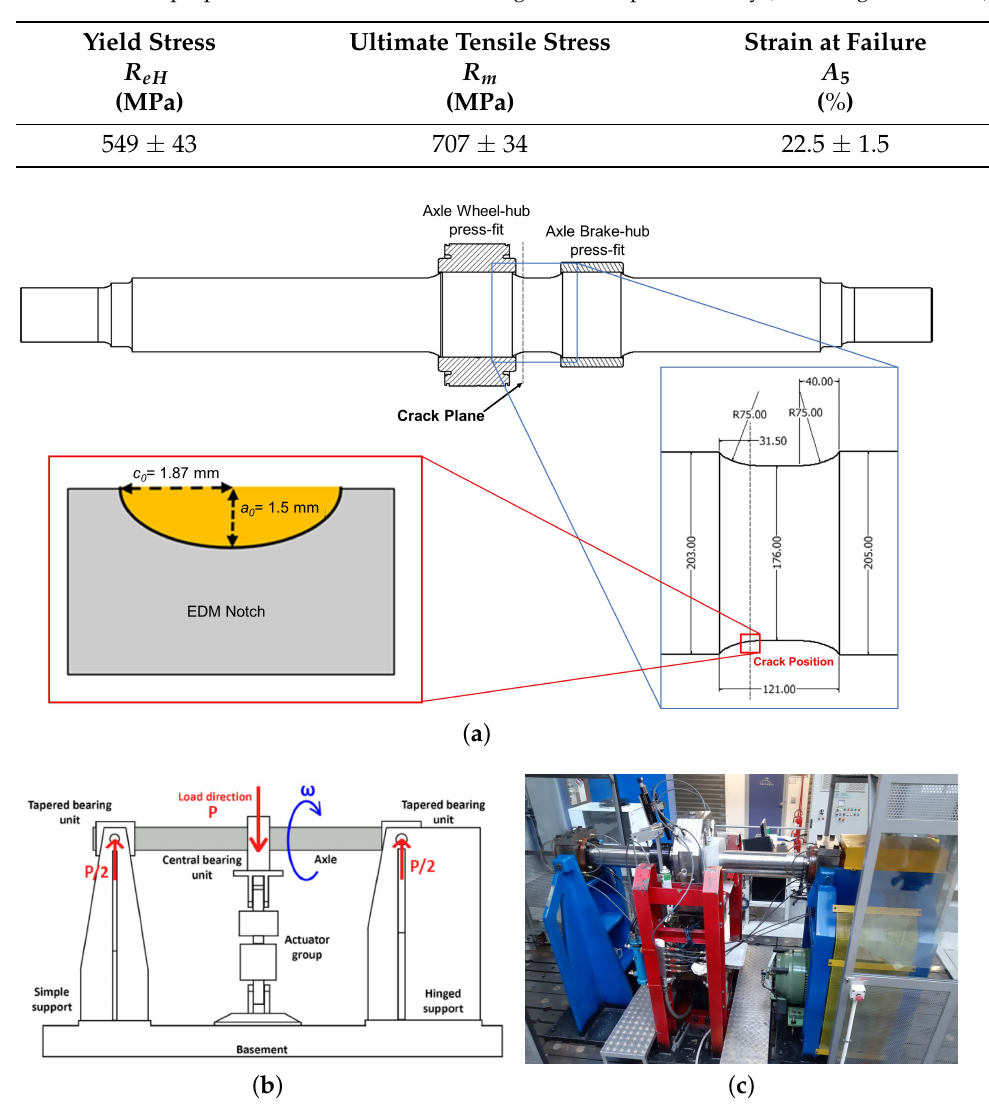
Figure 1. Experimental setup of the full-scale axle tests: ( a ) drawing of the specimen and EDM micro-notches location, and ( b ) schematic and ( c ) picture of the testing bench which reproduces the rotating bending on the full-scale